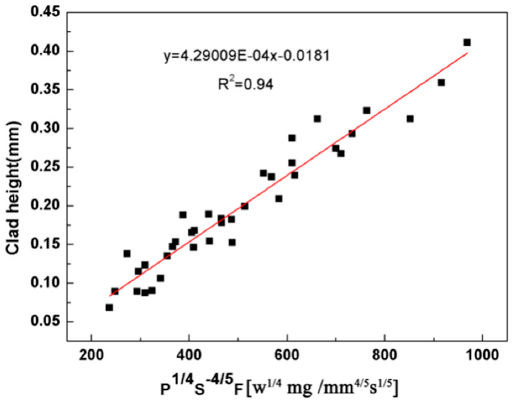
Figure 2. Relationship between the clad height and P 1/4 S − 4/5 F.